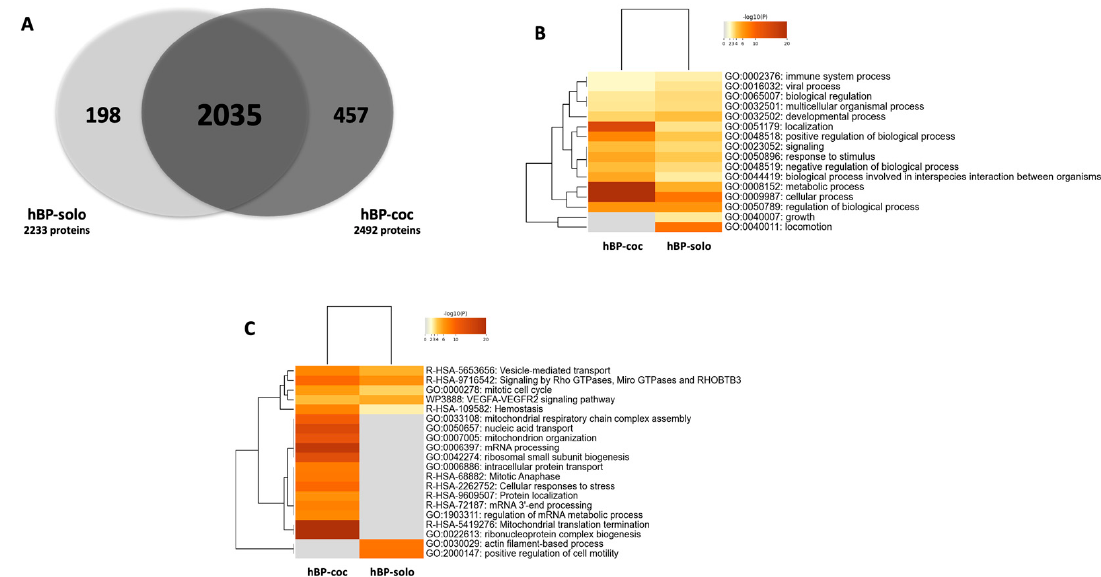
Figure 2. Libraries and functions of proteins identified as enriched in hBP-solo and hBP-coc conditions. ( A ) Venn diagram of the identified proteins in hBP-solo and hBP-coc conditions by DDA-MS analysis (2233 and 2492 respectively, N = 2, n = 10). Only proteins identified based on at least 2 peptides were included in this study. ( B ) Top-level gene ontology (GO) biological processes for hBP-solo and hBP-coc enriched proteins. ( C ) Dendogram of statistically enriched ontology clusters for hBP-solo and hBP-coc enriched proteins. − log10( p -values) represents the enrichment of protein candidates in each cluster.